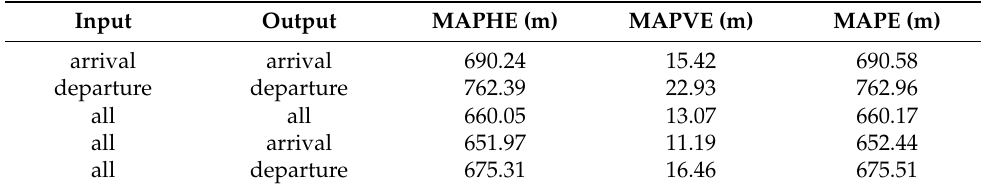
Table 3. Comparison of prediction errors of arrival and departure flights under different input